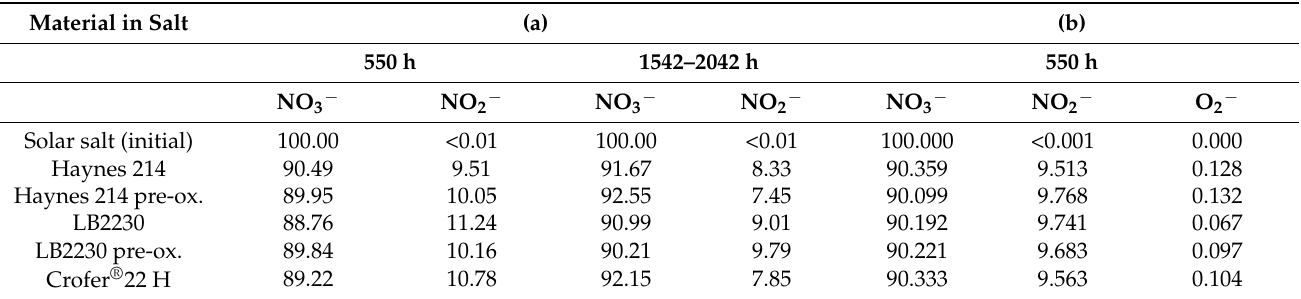
Table 5. Molar contents of NO 3 − , NO 2 − and O 2 − in solar salt after 550 h of discontinuous corrosion testing at 600 ◦ C in mol%. (a) Analysis by FZ Jülich, ZEA-3 and (b) double-analysis by DLR, Institute for Engineering Thermodynamics. Material in Salt